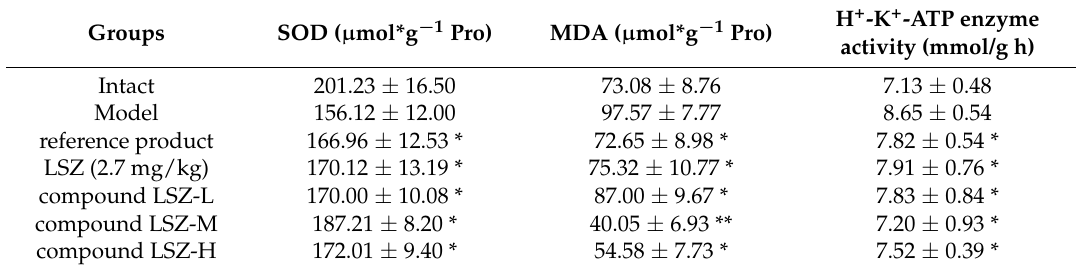
Table 3. Effect of compound LSZ capsuleon the activity levels of SOD, MDA and H + -K + -ATP enzymes. * p < 0.05 and ** p < 0.01 compared with model group (mean ± SD; n = 6).